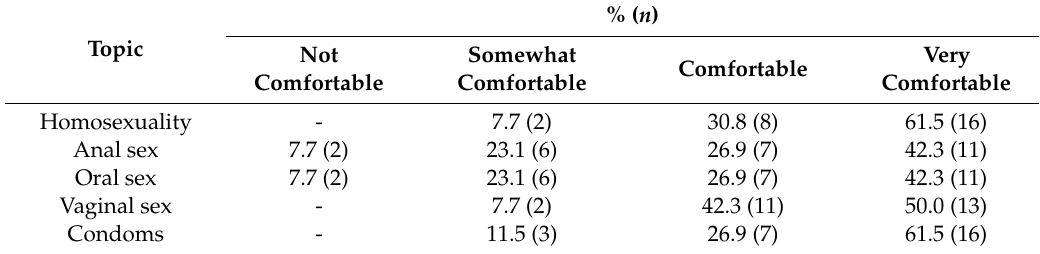
Table 2. Distribution of faith leaders’ comfort level discussing sexual health topics with adults ( n = 26). % ( n ) Topic Not Somewhat Comfortable